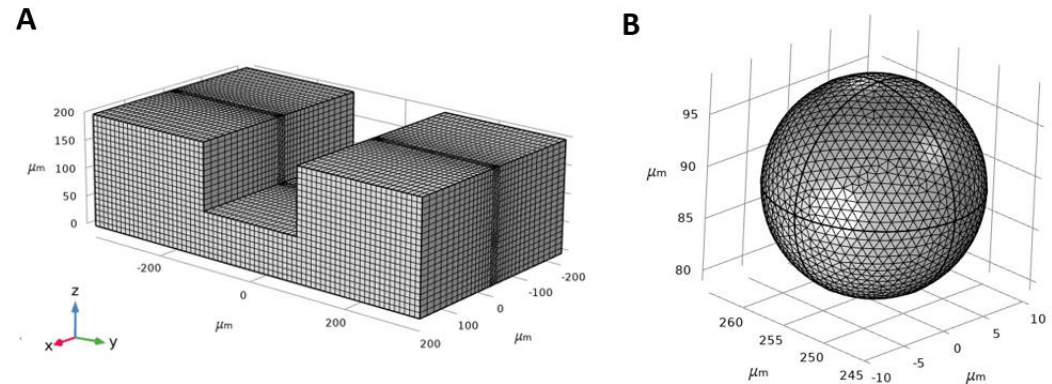
Figure 3. Illustration of the mesh in the fluid domain. ( A ) The domain was separated into two zones in which tetrahedral mesh was used between the particle surface and the microchannel walls with a maximum size of 0.1 × D p, and the structured mesh was used outside the block, including the particle. ( B ) Triangular mesh was used on the surface of the particle with a maximum size of 0.05 × D p .